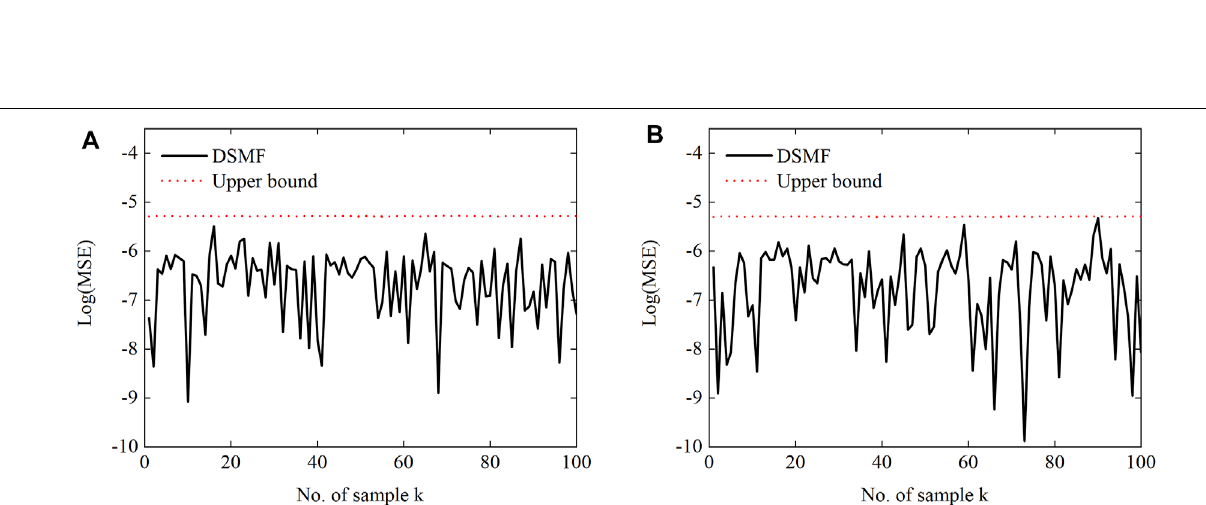
FIGURE 8 | The true and estimated values of a-phase at bus 4: (A) the real part of the voltage and (B) the imaginary part of the voltage.